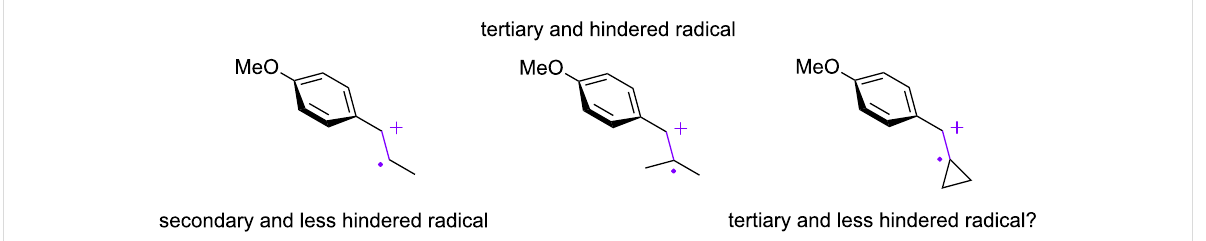
Figure 3: Formal expression of radical cations.